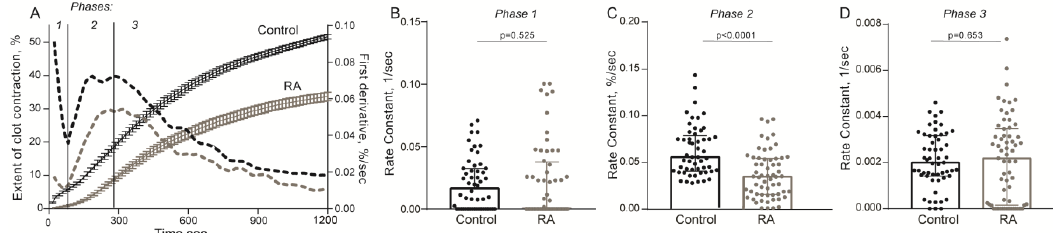
Figure 4. Comparative phase analysis of the averaged kinetic curves of clot contraction for RA patients ( n = 63) and control group ( n = 50). For the kinetic curves ( A ), transitions between phases 1, 2, and 3 of clot contraction were determined by finding local maxima and minima within the instantaneous first derivatives (dashed lines). The curves were fit using a piecewise function, and the rate constants of each phase were determined [33]. Rate constants of phase 1 ( B ), phase 2 ( C ), and phase 3 ( D ) are shown for RA patients and the control group. Data are presented as the median and interquartile ranges (25th and 75th percentiles) (Mann-Whitney U test).